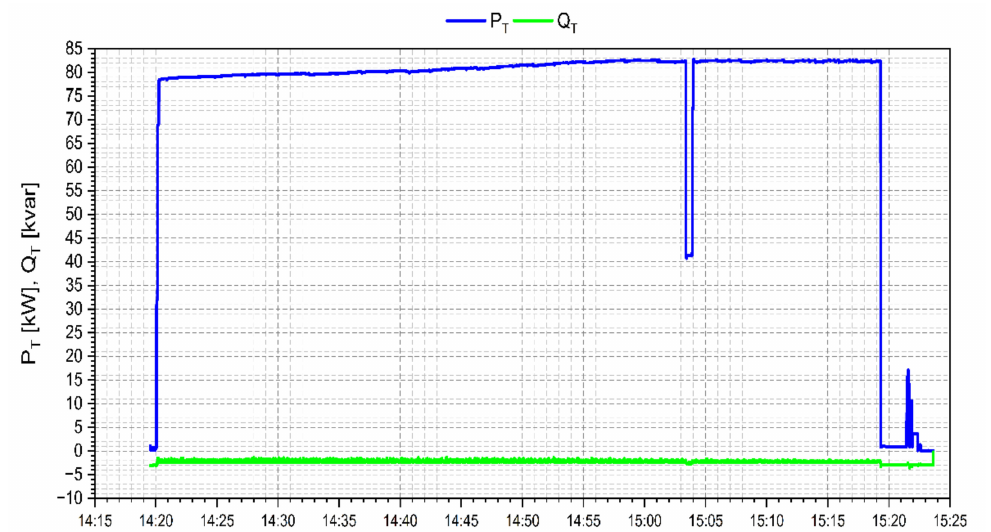
Figure 4. Power demand profile during one charging cycle (data aggregation interval: 50 cycles).